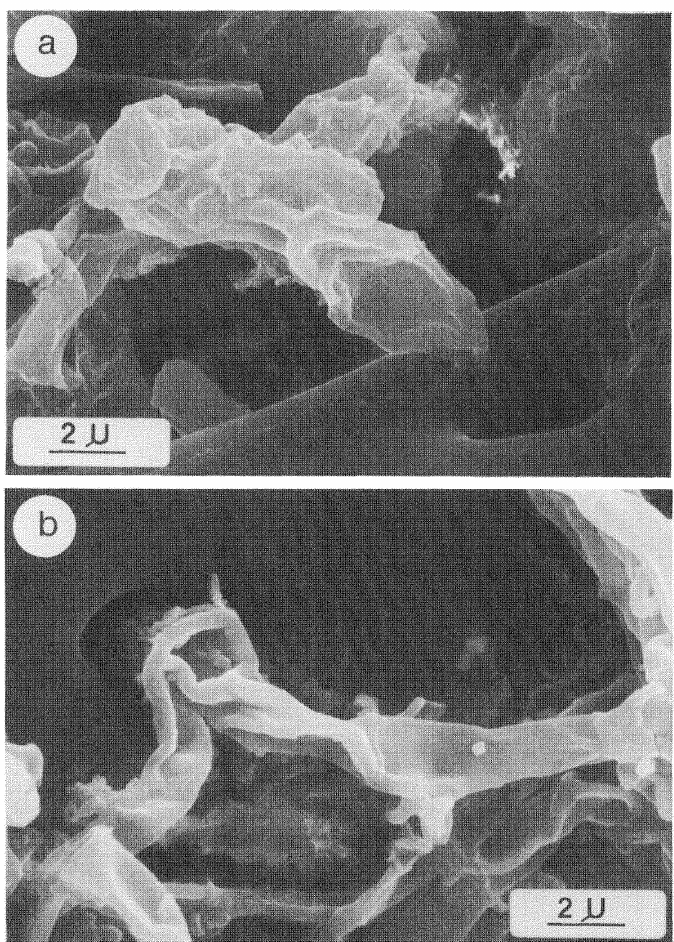
Fig. 6. Z. pallens (same individual as Figs. 4, 5). Pores from which surface coating seems to